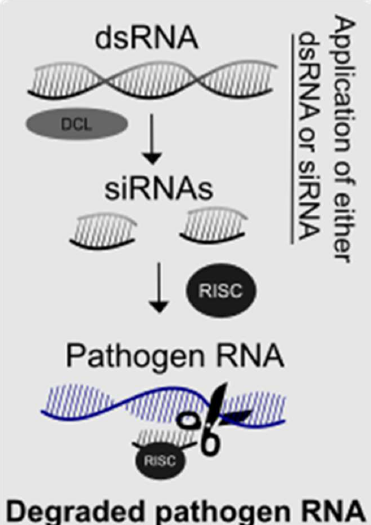
Figure 3. A brief overview of the RNAi pathway utilized for the application of RNAi-inducing molecules (dsRNA or siRNA) for gene silencing.